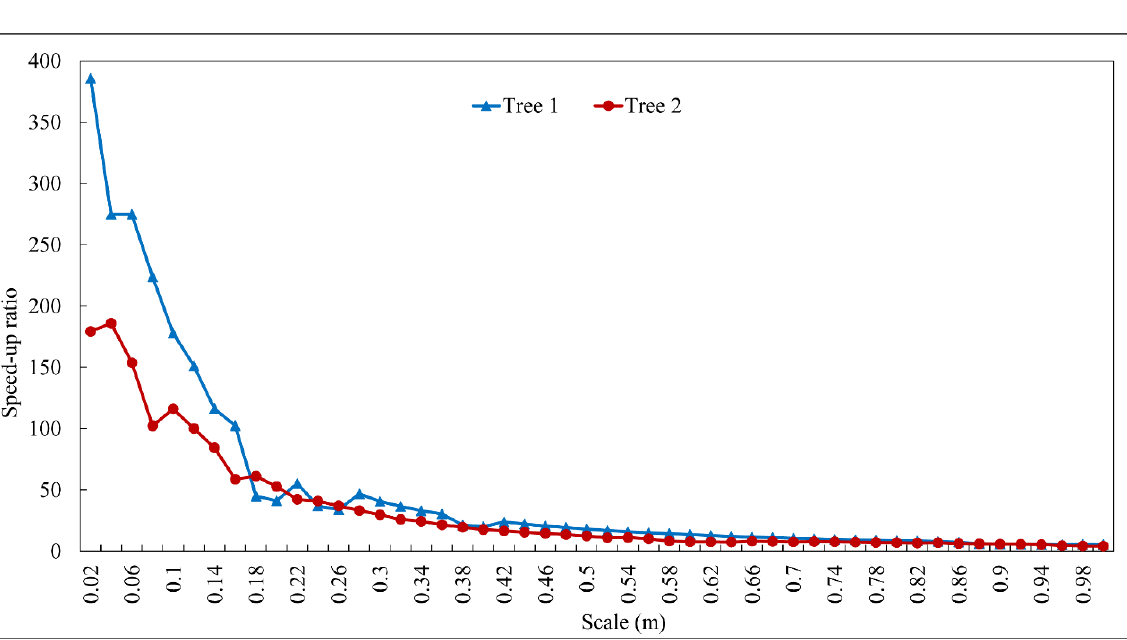
Figure 3. The balanced accuracy of each classifier for each tree. The balanced accuracy of multi-scale classifier is shown in the last column.